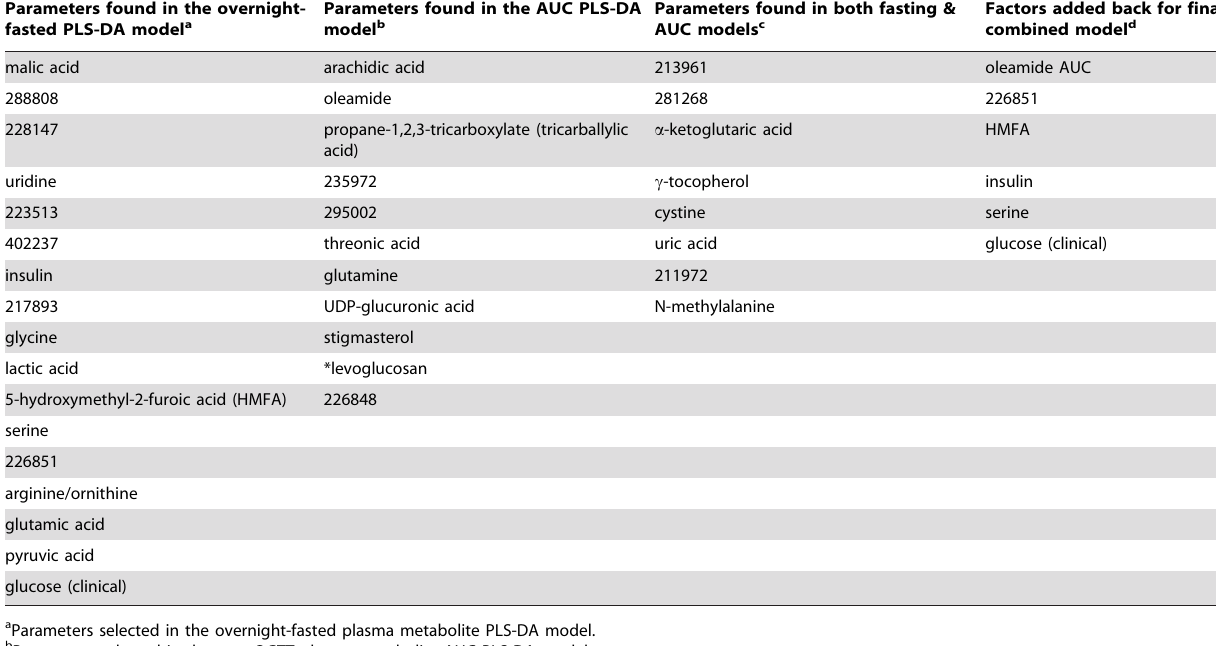
a Parameters selected in the overnight-fasted plasma metabolite PLS-DA model. b Parameters selected in the post-OGTT plasma metabolite AUC PLS-DA model. c Parameters observed in both the overnight-fasted metabolite PLS-DA model and the AUC-only PLS-DA model. d Parameters not found initially in the combined model, but added back because of their presence in either the the overnight-fasted metabolite PLS-DA model or AUC- only model. *adulterant in OGTT solution (see Results